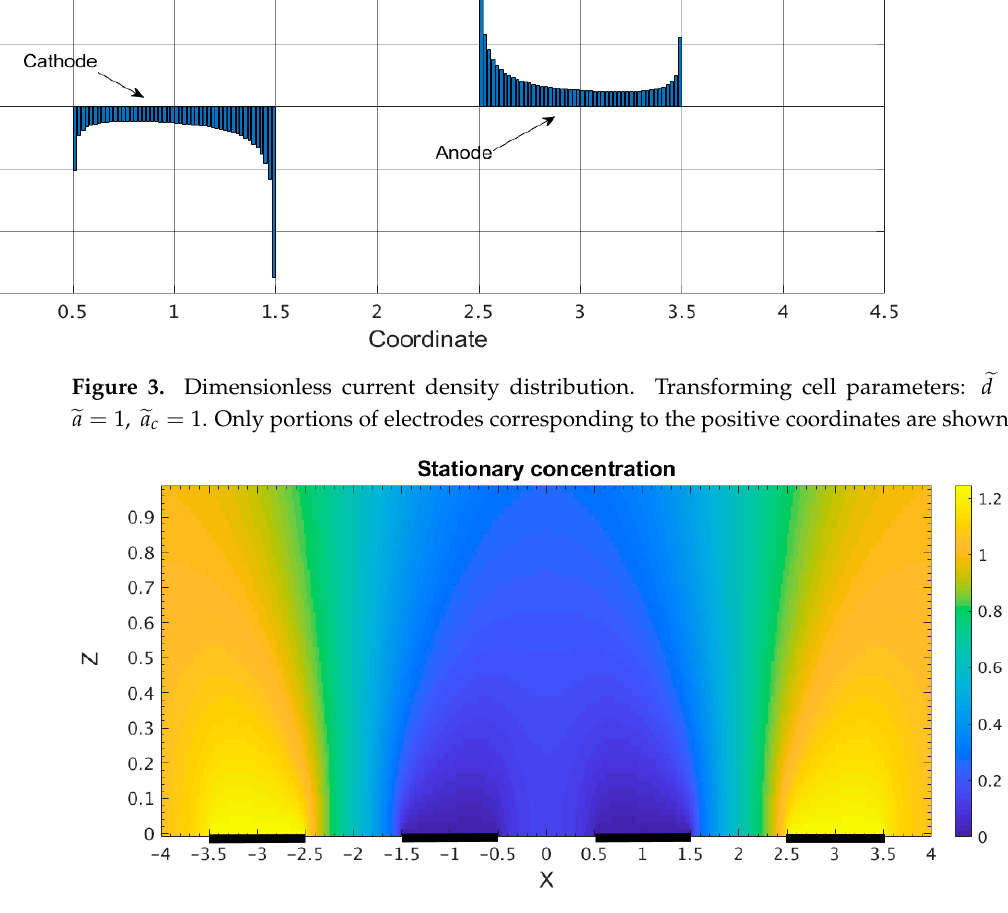
Figure 4. Dimensionless stationary concentration in the electrochemical cell vs. coordinates (shown by color). Thick black lines correspond to the electrodes position.